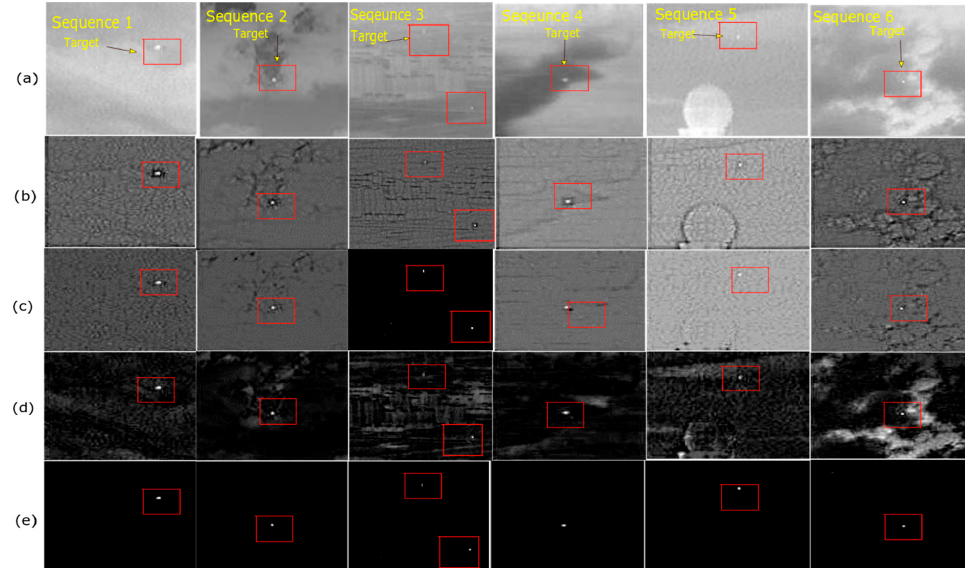
Figure 5. The target detection performances of the various methods on the image sequences presented in rows ( a – e ): ( a ) real image sequences; ( b ) max–mean; ( c ) max–median; ( d ) top-hat; ( e ) IPI.